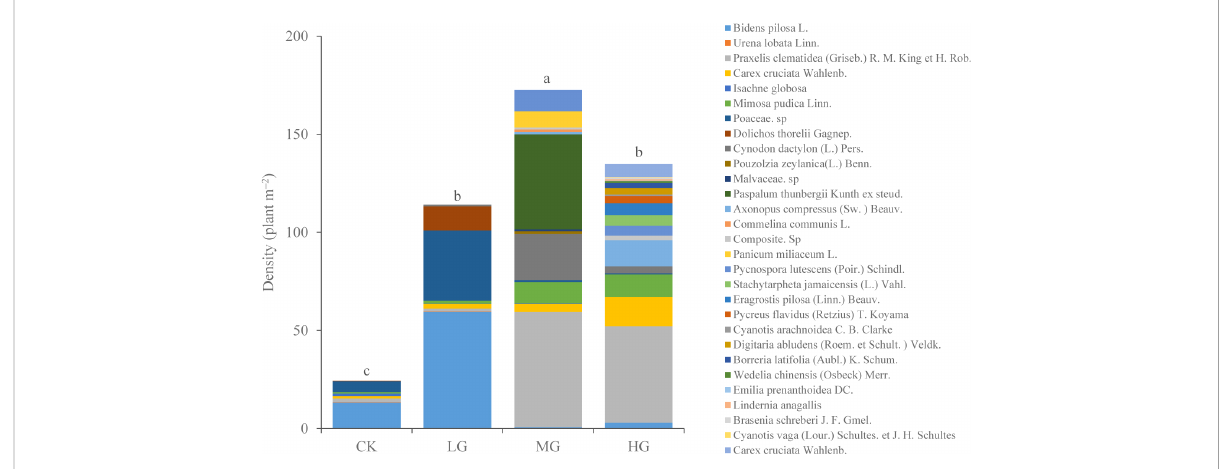
FIGURE 4 Aboveground species composition under different grazing intensities. The mean density of each species (n = 6). Different letters represent signi fi cant differences in total density among grazing intensities at the P = 0.05 level. (CK, no grazing, LG, light grazing, MG, moderate grazing, HG, heavy